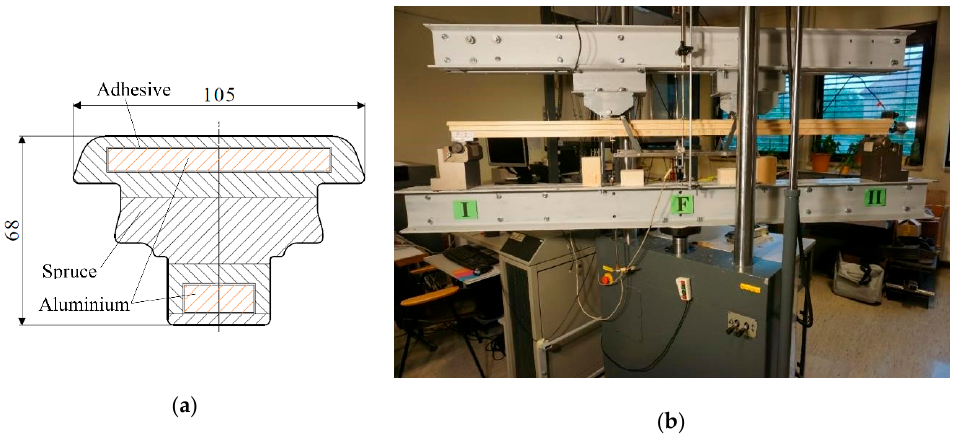
Figure 2. ( a ) Cross section of a specimen with aluminium reinforcement, ( b ) the test equipment for performing the 4-point bending tests [25] .